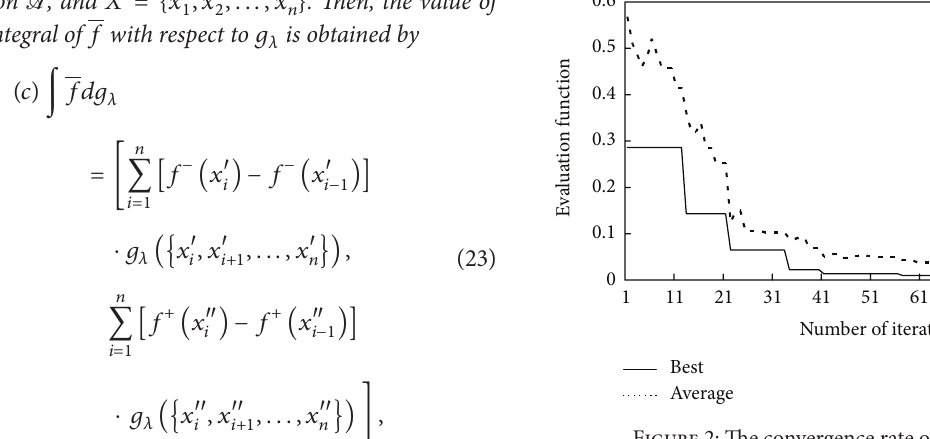
Figure 2: The convergence rate of Example